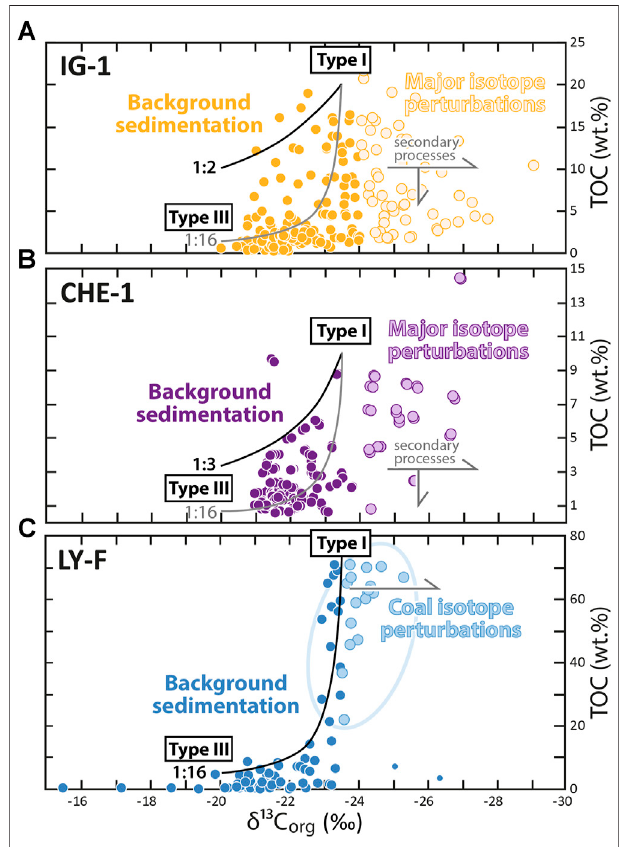
FIGURE 14 | Mixing model of Johnston et al. (2012) applied to the three majorstudied sections:Totalorganiccarbon(TOC) dependingonthe δ 13 C org ; only background sedimentation values are taken into account. In each case, the mean value for the Type III OM pole is − 20 ‰ , and for the Type I OM pole, − 23.5 ‰ . (A) TheIG-1datapresentamixingType III:Type Iratioof ∼ 1:2, (B) the CHE-1 data a ratio of ∼ 1:3 (high mixing), whereas (C) the LY-F data fi t with a ∼ 1:16 ratio (low mixing). On Figure (A,B) , this 1:16 ratio has been determined for the IG-1 core and CHE-1 core data in order to highlight the differenceinthemodelledcurveswhichwouldoccurincaseofalowermixing.